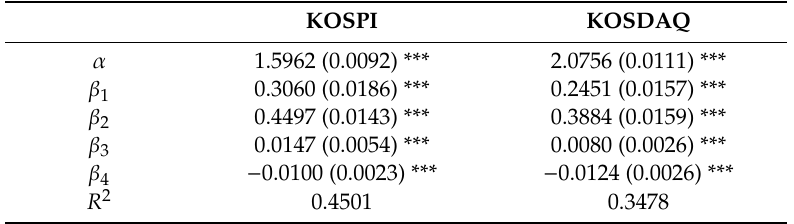
Table 4. Estimates of herding behavior in high- and low-trading volume periods.